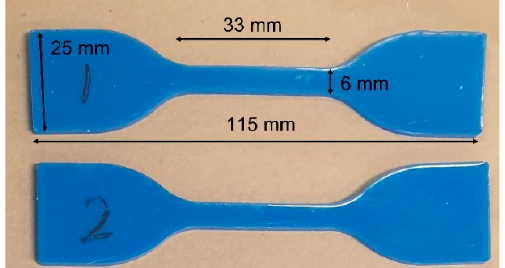
Figure 1. Tensile specimen shape based on ASTM D412 type-C standard.